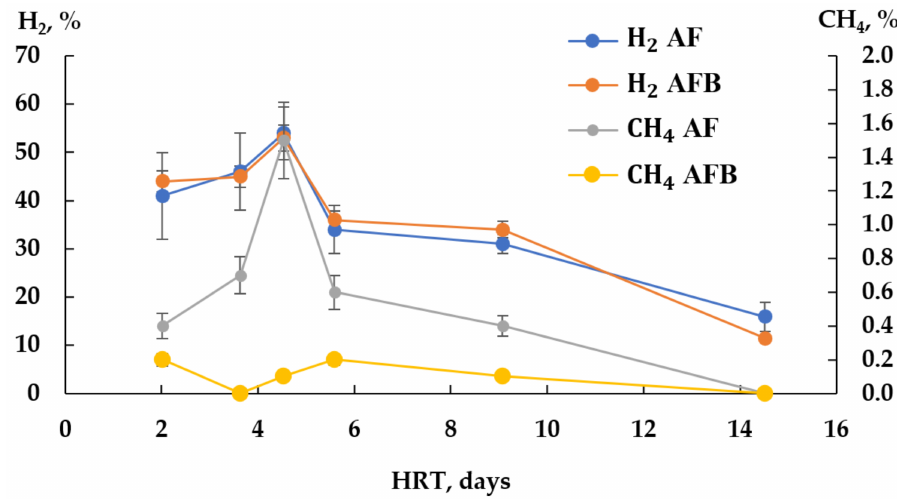
Figure 4. The concentration of hydrogen and methane in the biogas depending on hydraulic retention time (HRT).